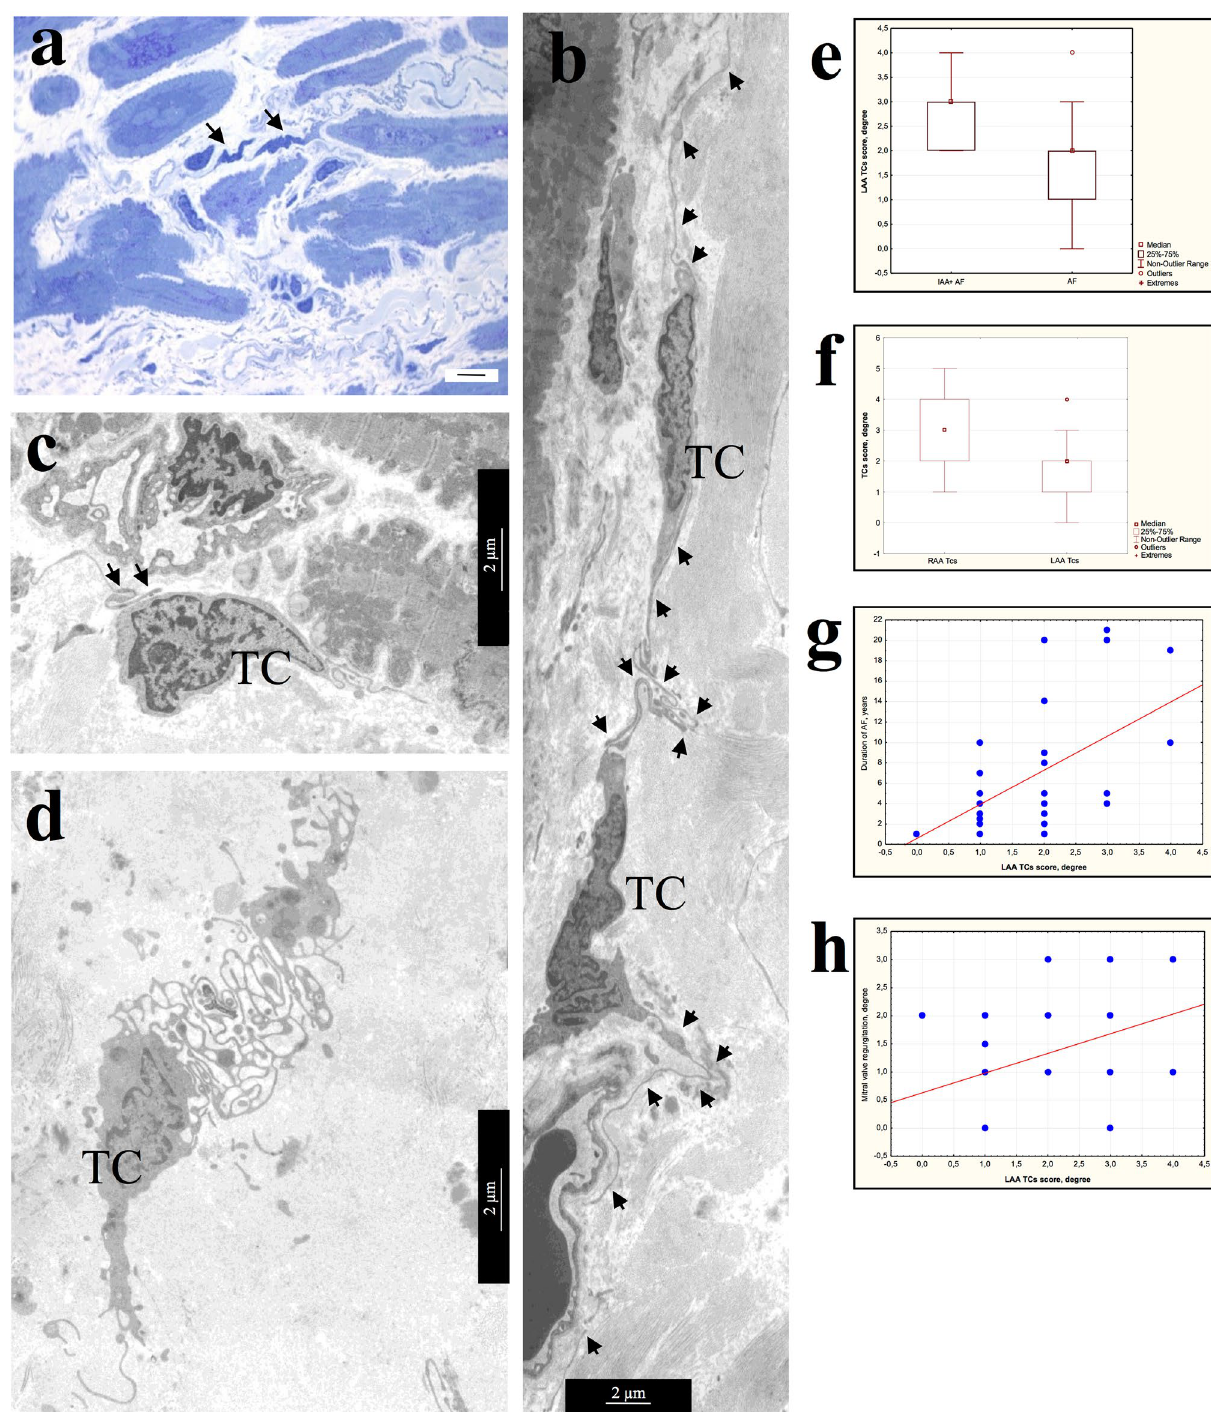
Figure 2. Morphology of TCs in atrial appendage myocardium of patients with AF. ( a ) Comparative morphology of TCs (arrows) and cardiomyocytes. Semi-thin sections. PAS reaction with methylene blue staining. bar 10 µm. ( b) Spindle-shaped and star-shaped TCs with 2–3 processes (arrows). ( c ) Contact of the TC process (arrows) with the “body” of another TC. ( b , c ) bar 2 µm. ( d ) TC with numerous branching processes that form a labyrinthic system. b-d Transmission electron microscopy (TEM). ( b , c ) bar 2 µm. TC—telocyte. ( e–h ) Semi-quantitative assessment of presence TCs in atrial appendage myocardium. ( e ) Comparison of TCs presence in LAA myocardium of AF + IAA patients and AF patients (Mann–Whitney test, p < 0.05). ( f ) The ratio of TCs score in LAA and RAA myocardium (Mann–Whitney test, p < 0.05). ( g , h ) Positive correlation of TCs score in LAA myocardium with the duration of AF ( g , r = 0.50; p = 0.0035), the degree of mitral valve regurgitation ( h , r = 0.37; p =